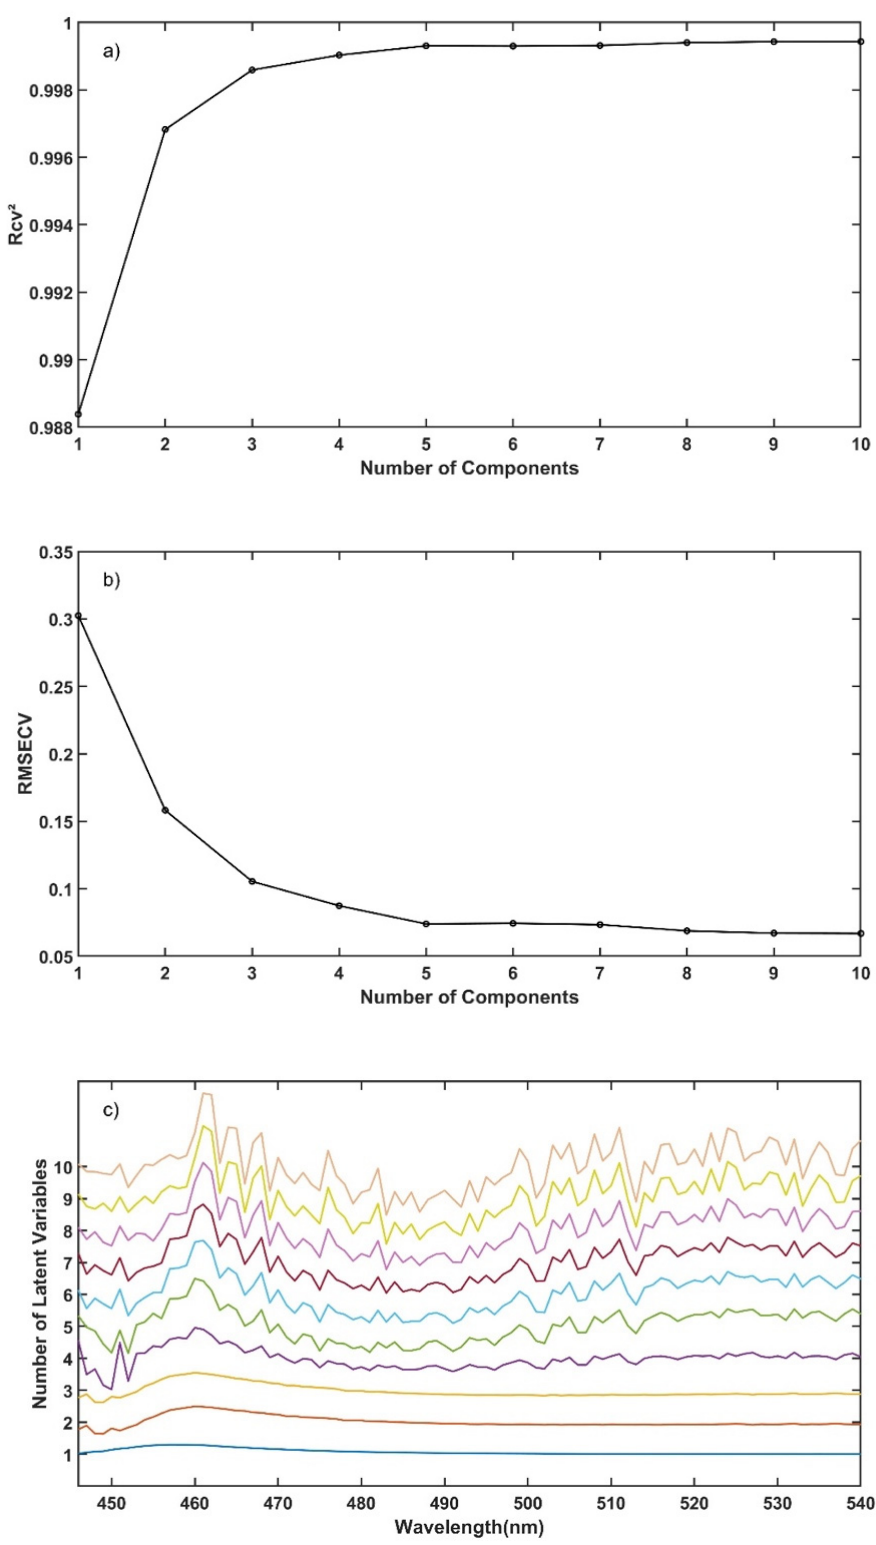
Figure 11. ( a ) R cv2 vs. number of components, ( b ) RMSECV vs. number of components and ( c ) stacked PLS regression vector for different number of latent variables vs. wavelength.